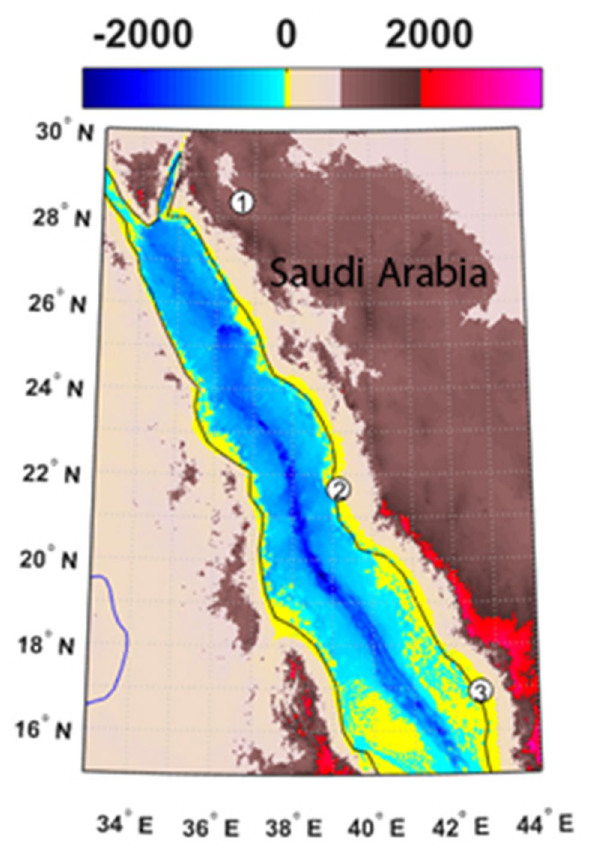
Figure 1. Digital elevation chart of the study area with the location of Tabuk (1), Jeddah (2) and Jizan (3) weather observation stations. Math Works, Inc. MATLAB. Version 2020a, Math Works, Inc., 2020. www. mathw orks.